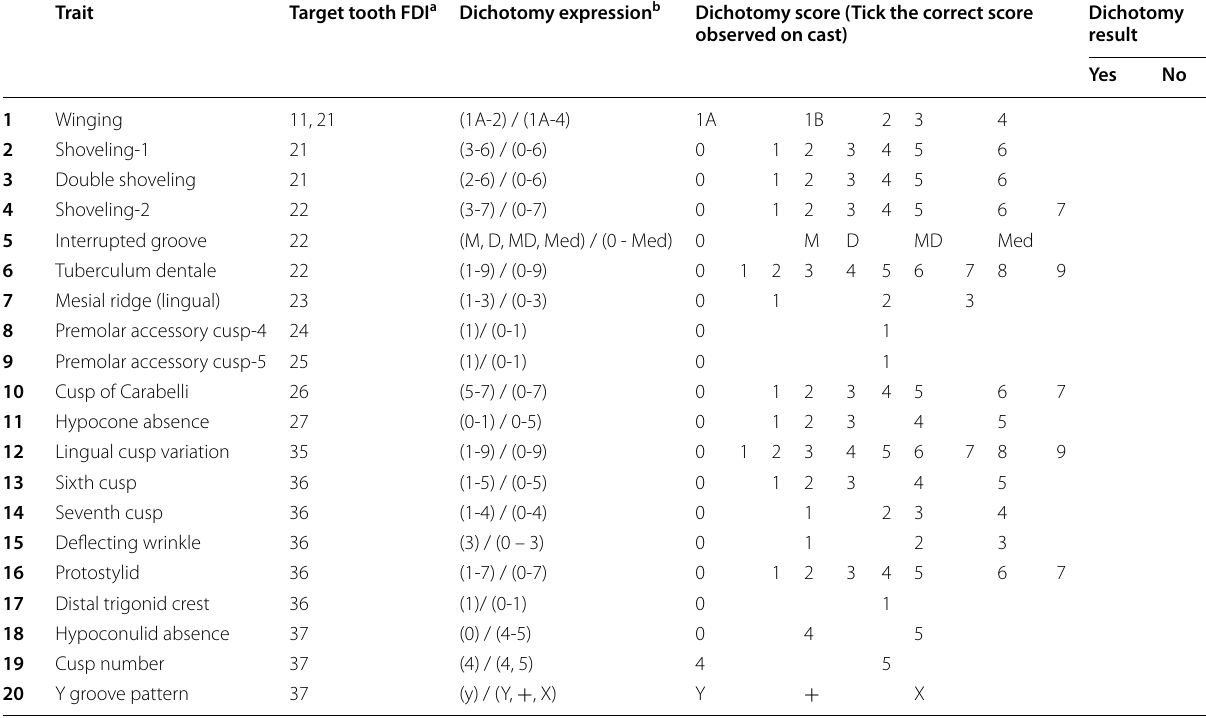
a Fédération Dentaire Internationale (FDI) tooth-numbering b (Present range of grades) / (total range of